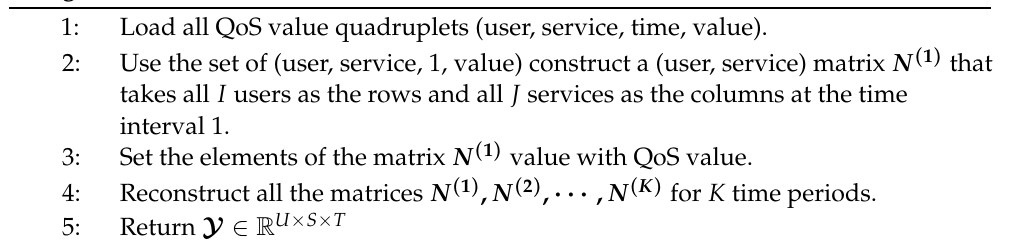
Algorithm 1: Tensor Construction